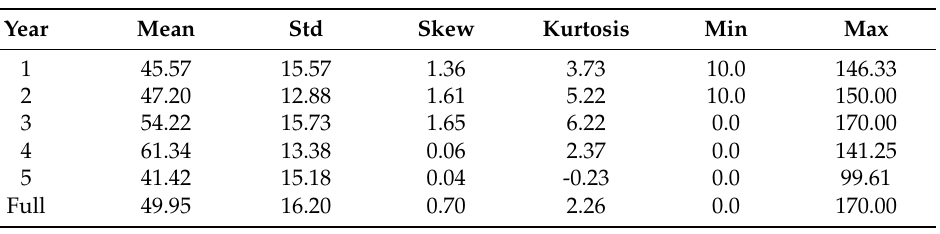
Table 2. Summary statistics of the electricity price for central–southern Italy. Prices in e /MWh. Hourly data from 1 July 2015 to 30 June 2020.